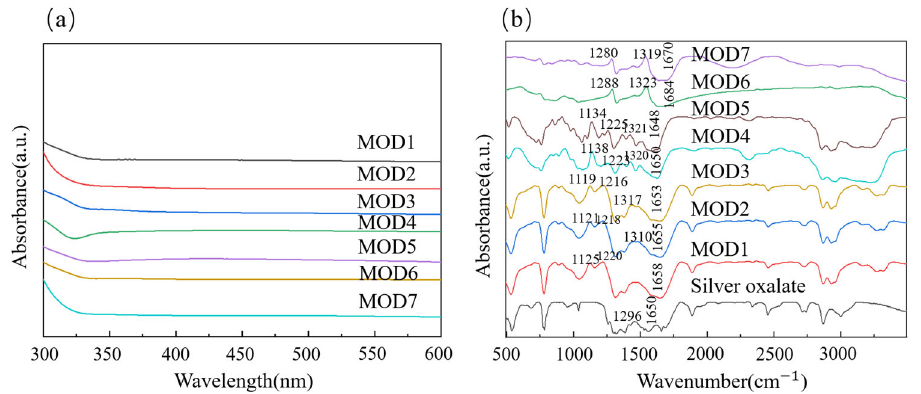
Figure 3. UV–visible and IR spectra of different MODs: ( a ) UV–visible spectra of different MODs, ( b ) IR spectra of different MODs. ( b ) IR spectra of different